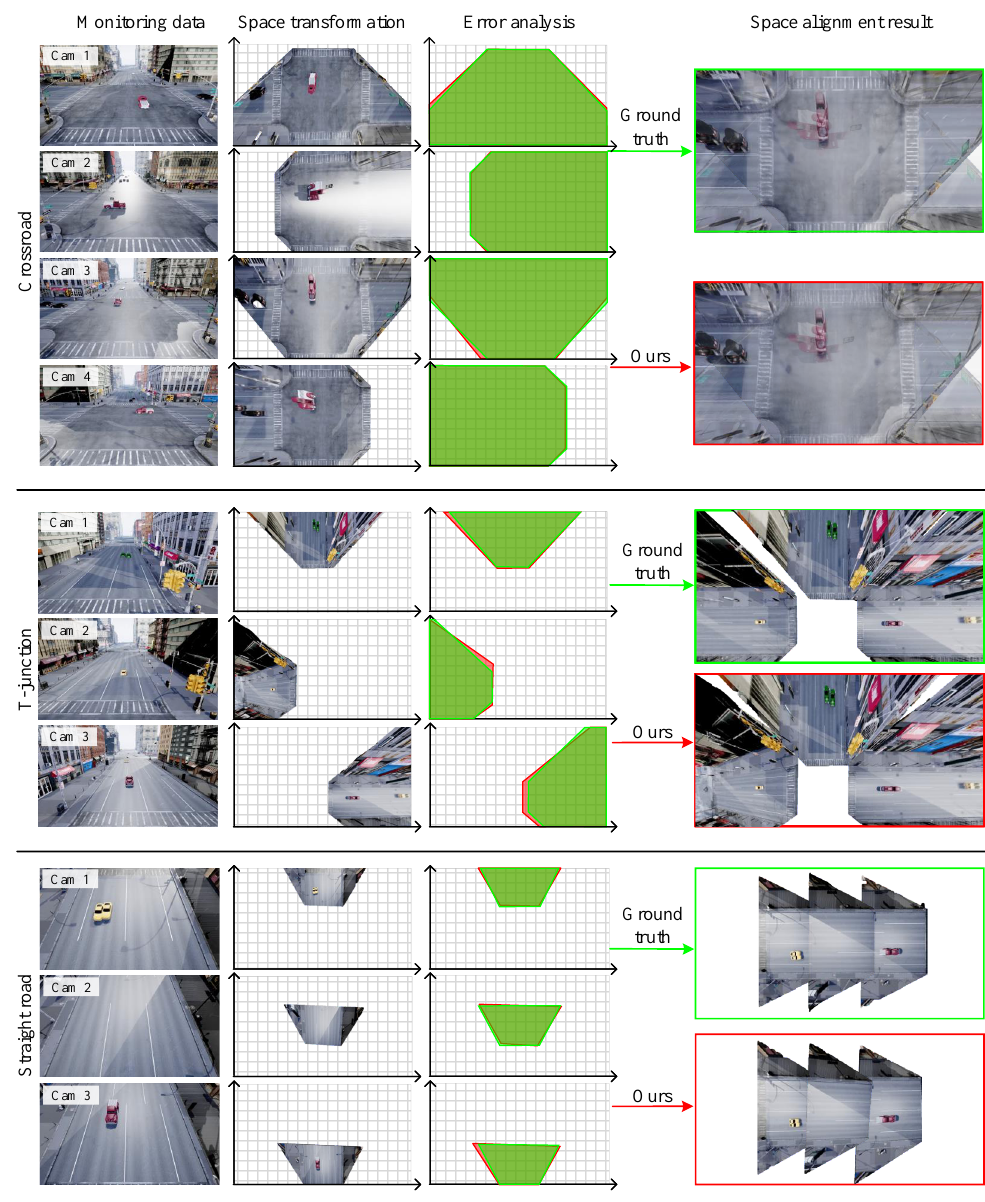
Figure 9. Some qualitative evaluation results of our proposed approach on simulation environment. Three groups of experiments conducted on crossroad, T-junction and straight road are displayed from top to bottom, respectively. Their space alignment results are shown in turn, including the monitoring data, space transformation and the comparison with ground truth. In these results, the ground truth is marked in green and our results are marked in